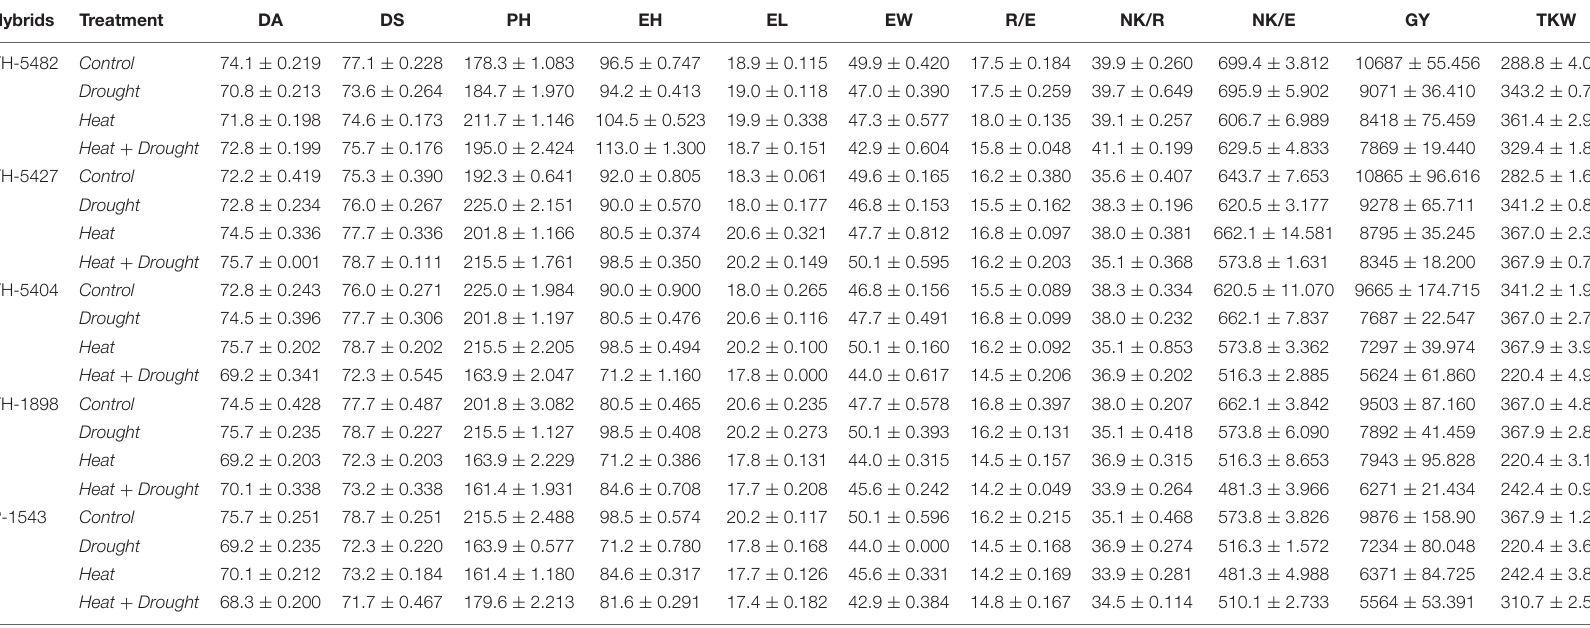
DA: Days to anthesis; DS: Days to silking; PH: Plant height (cm); EH: Ear height (cm); EL: Ear length (cm); EW: Ear width (mm); R/E: Number of rows per ear; NK/R: Number of kernels per row; NK/E: Number of kernels per ear; GY: Grain yield (Kg ha − 1 ); TKW: Thousand kernel weight (g). The values are obtained by pooling the mean data of three replicates of two spring growing seasons (2019–20 and 2020–21). ± SE (Standard